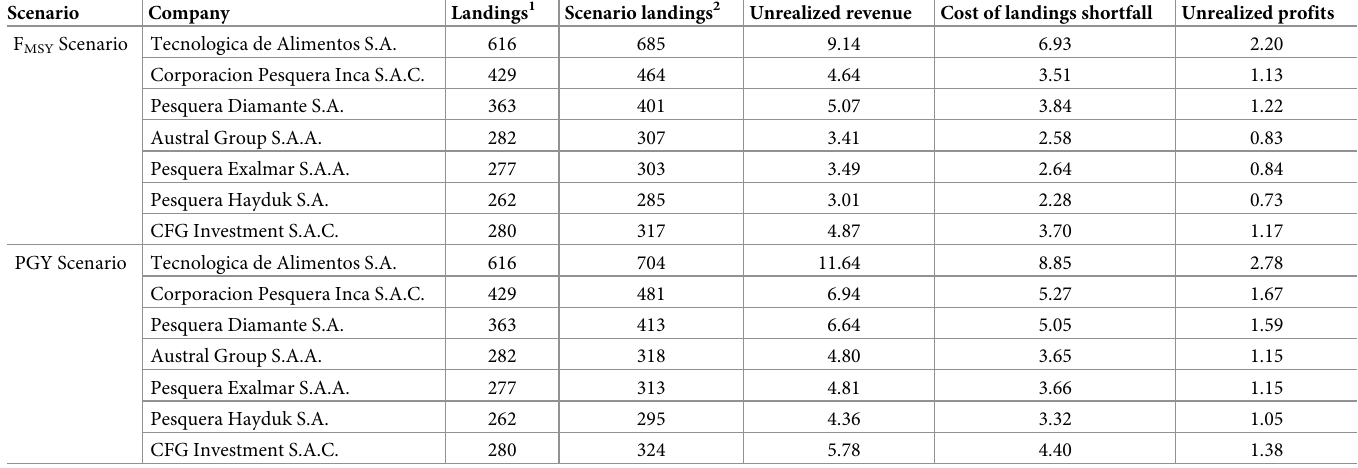
Table 3. Average attained landings for the top seven companies for 2011–2015 (10 3 t; accounting for 57% of landings in Peru), scenario landings (10 3 t) and their impact on revenue and profits (USD 10 6 ) for F MSY and PGY scenarios.